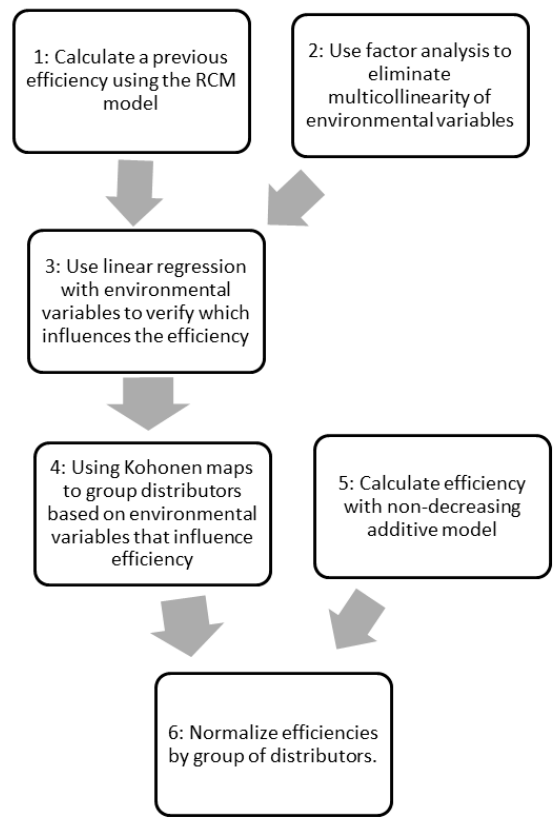
Figure 1. Diagram of proposed model.